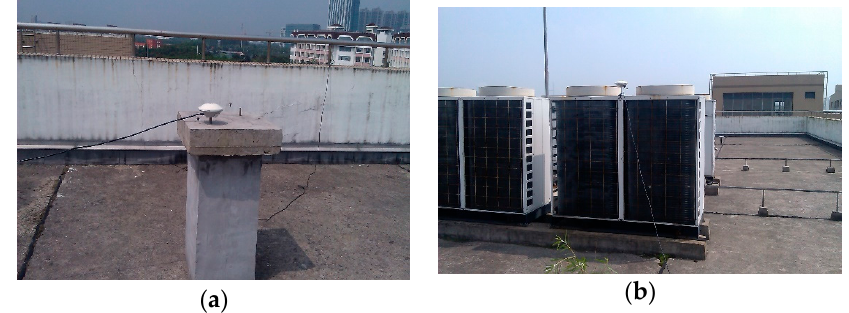
Figure 3. Set-up of the data collection at East China Normal University. Two antennas connect to the same GNSS receiver. ( a ) One antenna mounted on a concrete pillar (Latitude: 31.035631 ° N; Longitude: 121.444421 ° E); ( b ) the other antenna set on the top of an A/C compressor (Latitude: 31.035640 ° N; Longitude: 121.444550 ° E).